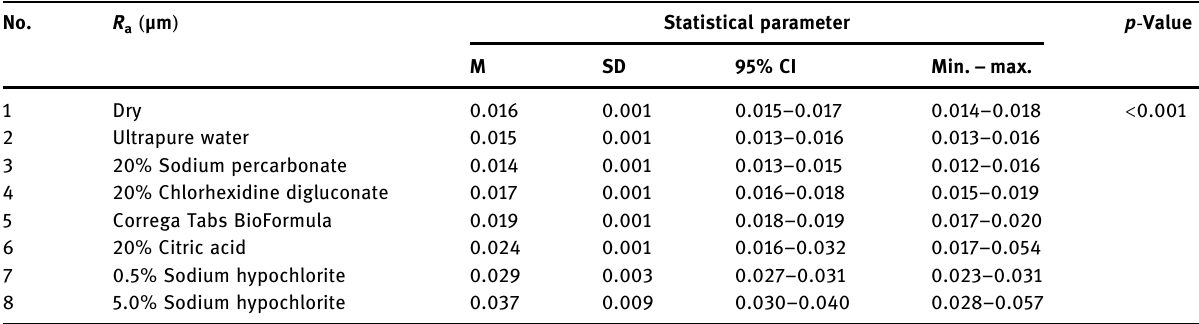
Table 2: Descriptive statistics for R a measurements outcome No.